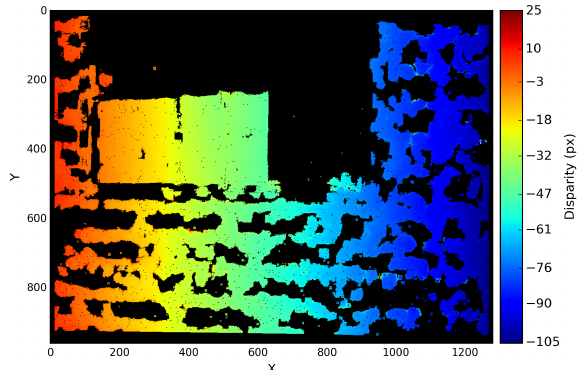
Figure 8 Disparity map using SIFT keypoints as seeds for GOTCHA stereo